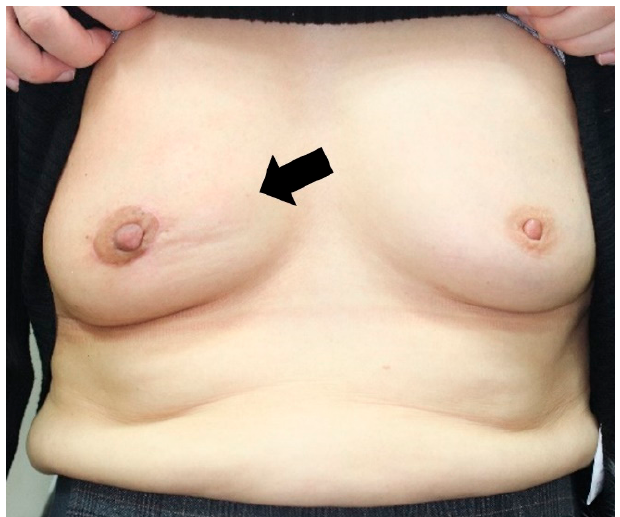
Figure 5. A 56-year-old patient’s 14-month postoperative photograph. The tumor was located in the upper inner quadrant of the right breast. And the resected breast tissue was 10 g, and 2 sheets of ADM were used. The black arrow indicates bulging deformity with severe hardness.